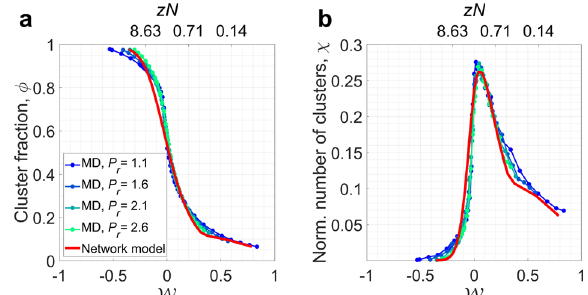
Fig. 3 | Comparison ofstructuralproperties. a Clusterfractionand b normalized number of clusters in the MD simulations and in the complex network model. The quantities are plotted as a function of the Widom self-similarity W (and corre- sponding link density, computed from Equation (10)), which collapses these quantities onto a master curve. The similarity in both quantities indicates that the network model predicts the behavior of the real system. Source data are provided as a Source Data fi